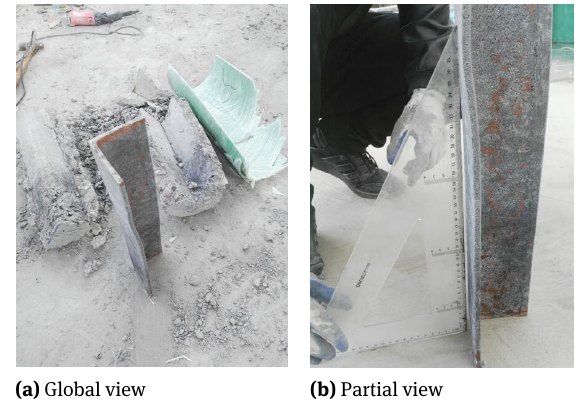
Figure 9: Shape of angle section steel after the GFRP tube and nano- silica concrete